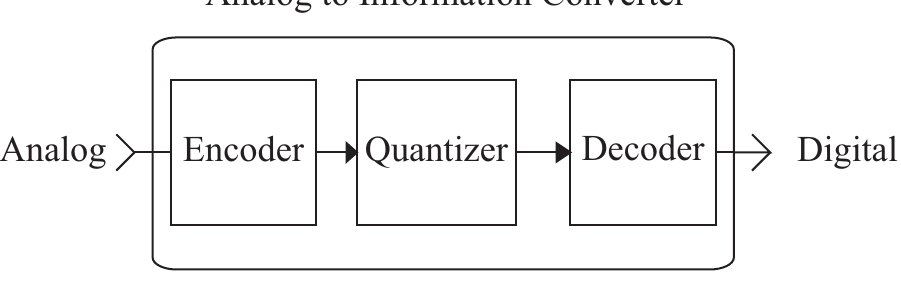
Figure 1. Analog to information converter